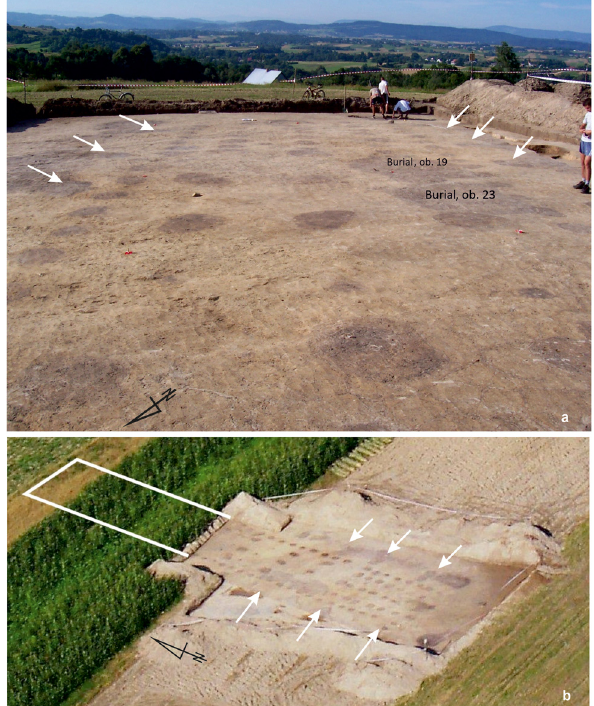
Figure 7: Ł oniowa, com. D ę bno, site 18, house 2. A general view for the southern part ( a ) and an aerial photo of the house during excavations ( b ) . White arrows indicate apses in clay pits. Photo by